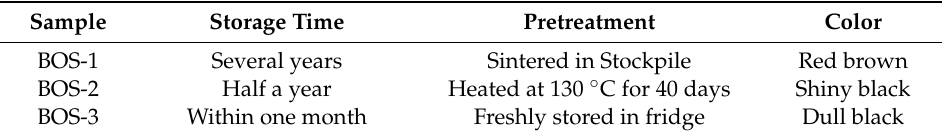
Table 1. The information of the three different BOS filter cake samples. Sample Storage Time Pretreatment Color BOS-1 Several years Sintered in Stockpile Red brown BOS-2 Half a year Heated at 130 ◦ C for 40 days Shiny black BOS-3 Within one month Freshly stored in fridge Dull